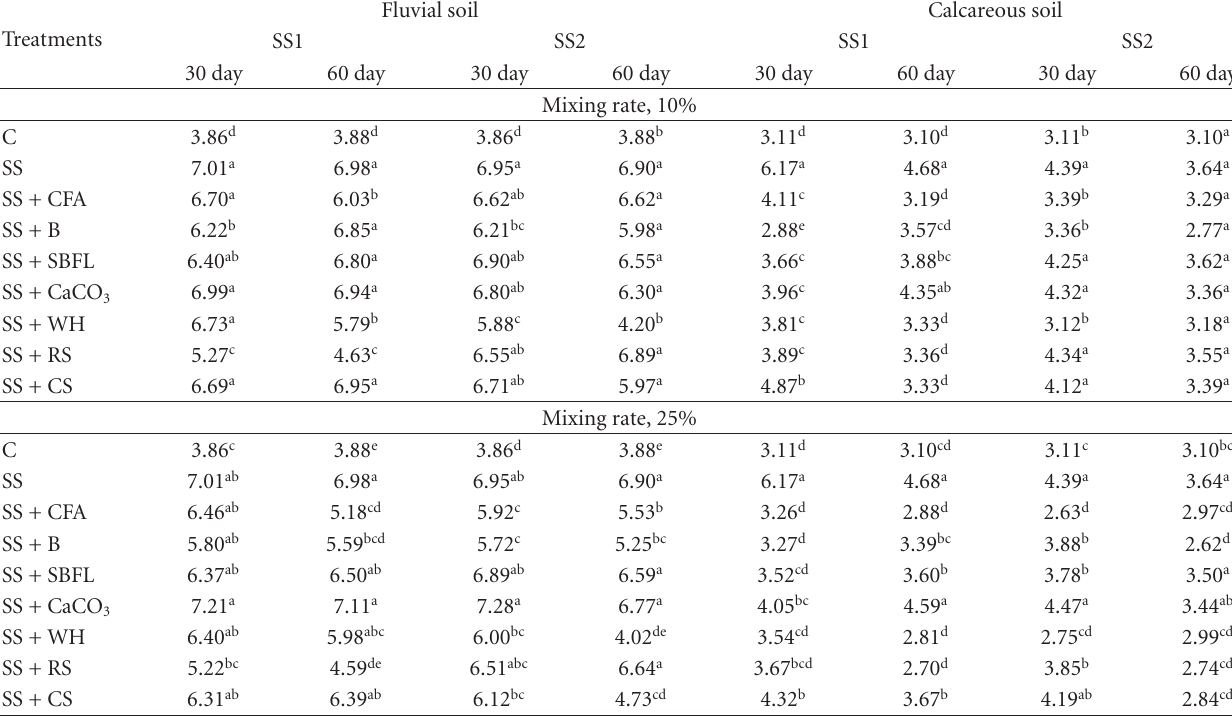
Table 7: E ff ect of sewage sludge and stabilized sewage sludge on the DTPA-extractable copper in relation to soil type, sewage source, mixing rate, and incubation